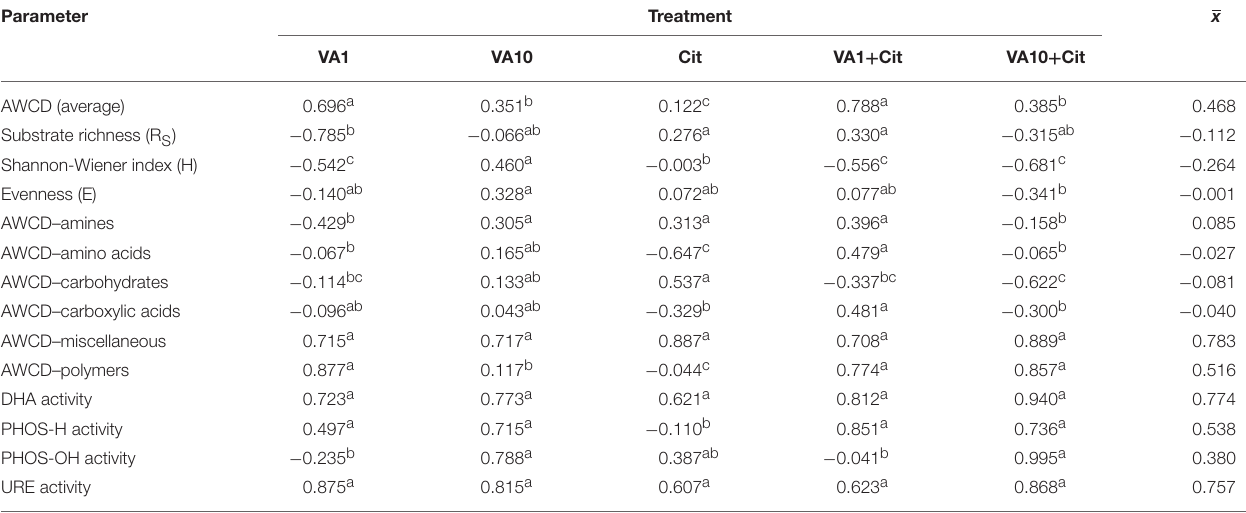
TABLE 2 | Values of the resilience (RL) index for measured parameters obtained at the end of the experiment. Parameter Treatment